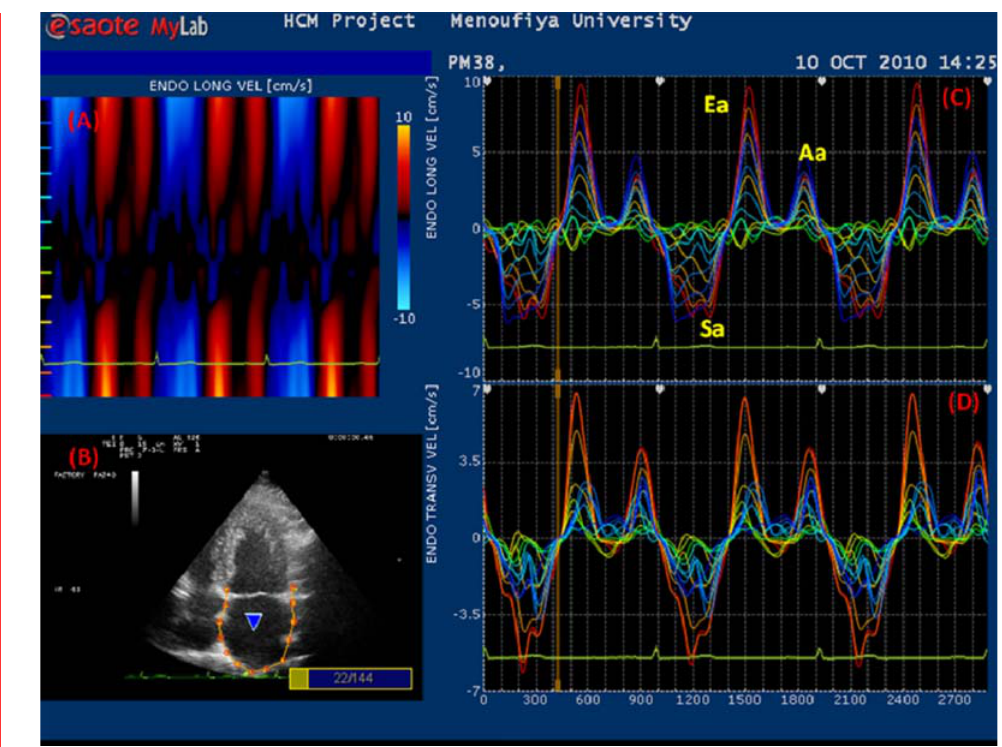
Figure 2. Assessment of LA wall velocity using VVI. A: Curved M-mode of LA longitudinal velocity. B: Tracing of the LA endocardial border in apical 4-Ch view showing velocity vectors. C: longitudinal. D: Transverse velocity– time curves from LA segments. (Sa: atrial systolic velocity, Ea: early atrial diastolic velocity, Aa: atrial late diastolic